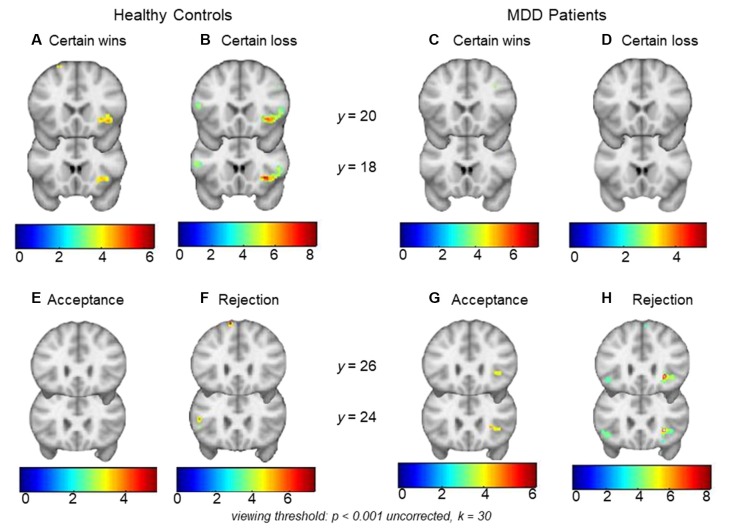
Top row: panels (A) and (B) show right anterior insula (AI) activations during monetary certain wins and losses (minus neutral) respectively in healthy controls (HCs). Within-group analysis showed significant activations during monetary wins and loss in the right AI. Within-group analysis in major depressive disorder (MDD) did not show significant right AI activations either during (C) monetary wins or during (D) monetary loss (minus neutral). Bottom row: panels (E) and (F) show an absence of activation in HCs during social acceptance and rejection (minus neutral), whereas (G) and (H) show right AI activations during social acceptance and social rejection (minus neutral) in MDD patients. Within-group analysis showed significant activations during social rejection and a trend for significant activations during acceptance in the right AI. Viewing threshold: p < 0.001 (uncorrected), k = 30. Color bars represent range of t-values. Coronal sections of the brain are presented with the montreal neurological institute (MNI) y coordinates.